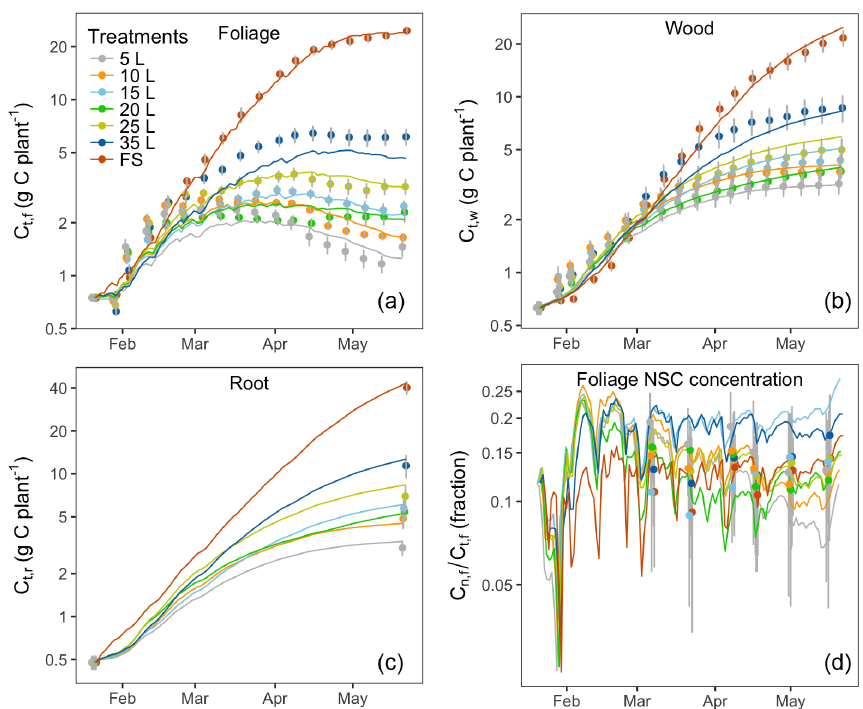
Figure 2. C stocks (lines) with the inferred parameter set and corresponding observations (symbols): (a) total C mass in foliage C t , f , (b) total C mass in wood C t , w , (c) total C mass in root C t , r and (d) foliage NSC concentration (C n , f / C t , f ). Note that the carbon pools and foliage NSC concentration ( y axes) are plotted on log scale to visualize the changes at the beginning of the experiment. Error bars (1SE, n = 6) are shown for each